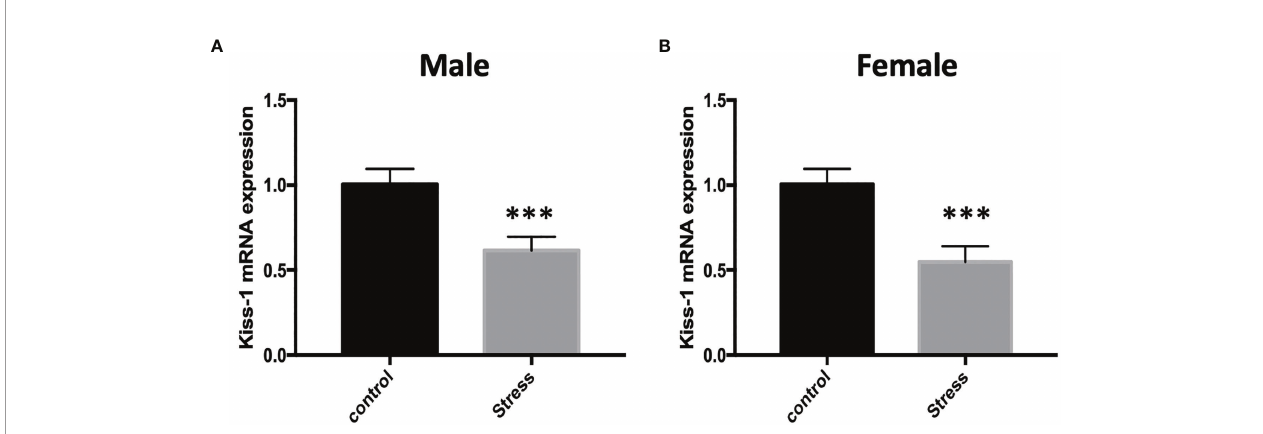
FIGURE 5 | The effect of chronic restraint stress on the expression of Kiss1 mRNA in the hypothalamus. control: control group, stress: restraint stress group. n=5. ***Represents the comparison with the control group, P<0.001. (A) Kiss-1 mRNA expression after chronic restraint stress in male mice; (B) Kiss-1 mRNA expression after chronic restraint stress in female mice.